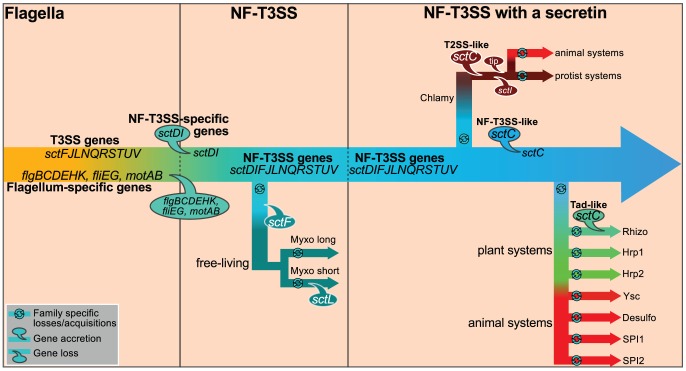
Proposed scenario for the evolution of NF-T3SS.We propose that genes common to the flagellum and the NF-T3SS were present in the flagellar ancestor of NF-T3SS. They are designated as “T3SS genes”. Then we detail the evolution of this system to the extant NF-T3SSs. First, the loss of flagellum-specific genes resulted in loss of the motility function. Presumably this system kept the ability to translocate or secrete proteins. The ancestral NF-T3SS experienced a series of gene losses and gains while diversifying to the ancestor of all extant NF-T3SSs. One early lineage derived into the Myxo systems by loss of some genes, notably SctF. Acquisition of secretins and of a few other genes allowed the formation of ancestral contact-dependent protein secretion systems, and the concomitant ability to subvert eukaryotic cells by direct delivery of effectors in their cytosol. Secretins were recruited to the NF-T3SS at least three times from three different cell machineries. Finally, the NF-T3SS quickly diversified and adapted to different host cells. Some components of NF-T3SS, such as the translocon proteins (YopB/YopD), the needle length determinant (SctP) or the needle tip (LcrV), cannot yet be integrated in this schema because of low or undetectable sequence similarity among T3SSs. Structural and sequence similarities were previously noted between translocon proteins of Chlamydia (CopB) and Salmonella (SipB) [142]. In contrast, we found no more than 28% identity over less than half of the protein when aligning CopB with all complete genomes in GenBank after excluding Chlamy proteins (Blastp, e-value>0.05). We also did not find significant sequence homologs of YopB/YopD in the NF-T3SS of Myxo or plant-associated bacteria. Since the translocon is required for protein delivery but not for secretion [35], it might have been acquired after the secretin. Balloons indicate gene losses and accretions. Only genes mentioned in the main text are shown. Abbreviated names of taxa are as in Figure 4.